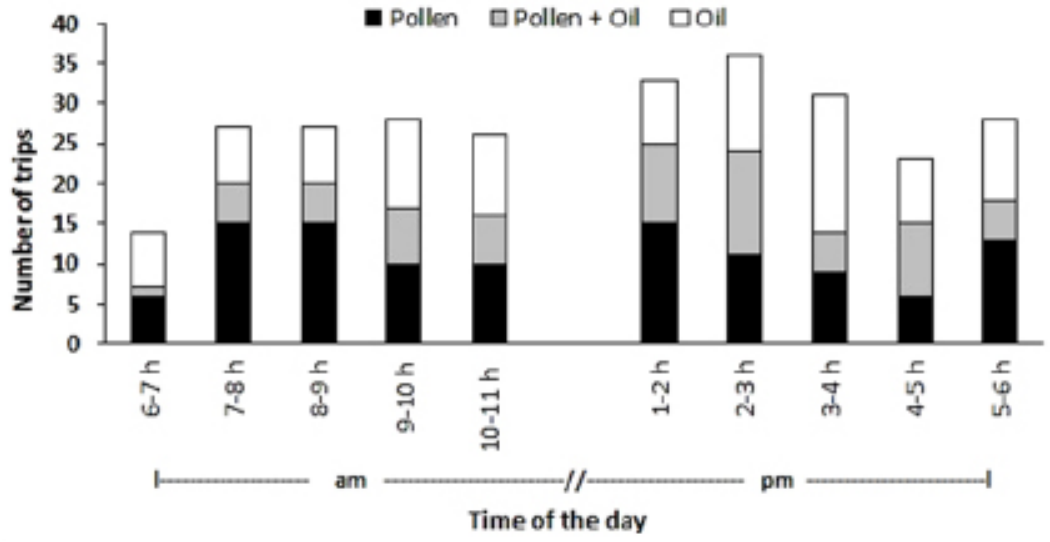
Fig 6. Number and diurnal distribution of trips carried out by females of Epicharis dejeanii , at Ilha do Superagui, Brazil, to collect the three classes of resources: pollen, pollen + oil and oil. // = period without observations on bee